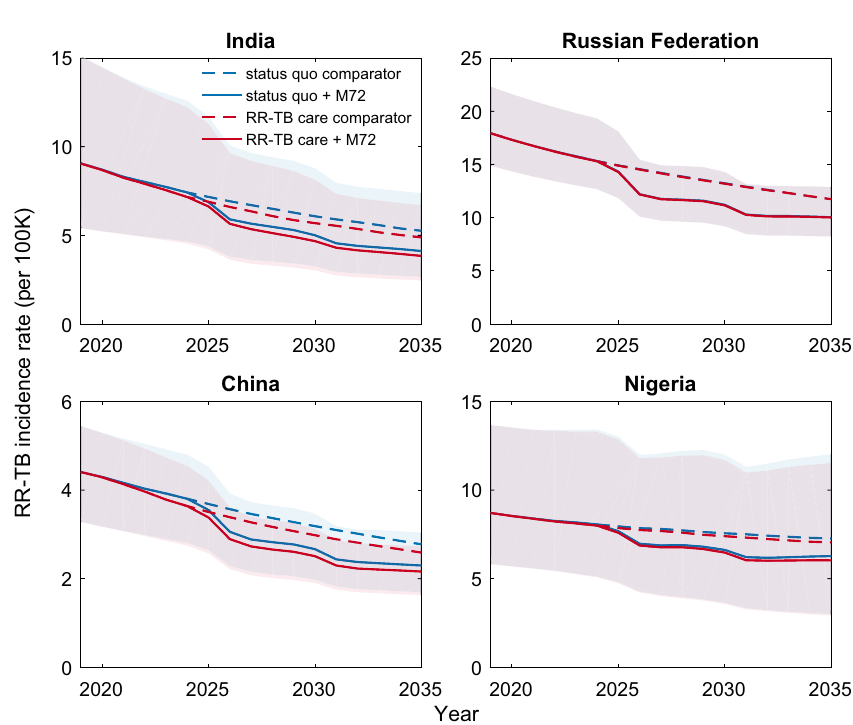
Fig. 1 Illustration of the projected impact on RR-TB of an M72-like vaccine. n = 200 posterior samples. Median (solid and dashed lines) and 95% Bayesian credible intervals (CrIs) of rifampicin-resistant tuberculosis (RR-TB) incidence rates over 2019 – 2035 are presented. For clarity, uncertainty regions with CrIs are only shown for the vaccine (not comparator) scenarios. These projections correspond to a post-exposure vaccine that reduces the risk of reactivation of latent TB infection by 50%, and that is implemented through routine vaccination and catch-up campaign amongst those over 15-years old. The fi gure shows projections for the countries with the highest absolute burden of RR-TB from each of the country categories listed in Table 1. Blue dashed curves illustrate a ‘ status quo ’ baseline, assuming no vaccine implementation and no change in the management of RR-TB. Blue solid curves show the impact of vaccination. Red curves show corresponding dynamics, under an alternative ‘ improved RR-TB management ’ baseline where the detection of RR-TB at the point of TB diagnosis is increased to 85%, and second-line treatment success is increased to 75%, in countries that have not yet achieved these targets. The Russian Federation in particular shows a lower impact of improved RR-TB management than other countries, owing to its already-higher coverage of drug susceptibility tests (Supplementary Fig. 10). Although the 95% CrIs for these projected dynamics with vaccination overlap in these regions, the overall incidence reductions are signi fi cant, in the sense of having uncertainty intervals that are strictly positive (Table 2, Supplementary Fig.